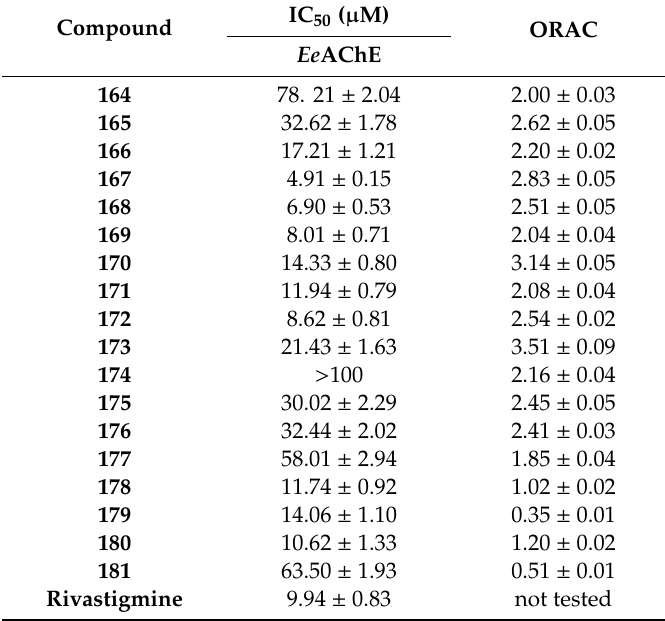
Table 26. AChE inhibition activity and oxygen radical absorption capacity (ORAC) of compounds 164 – 181 , expressed in Trolox equivalents.